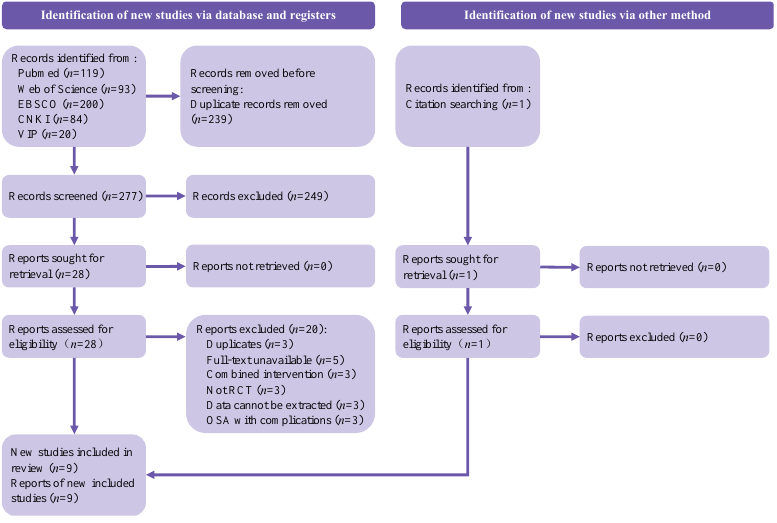
Figure 1. PRISMA diagram.